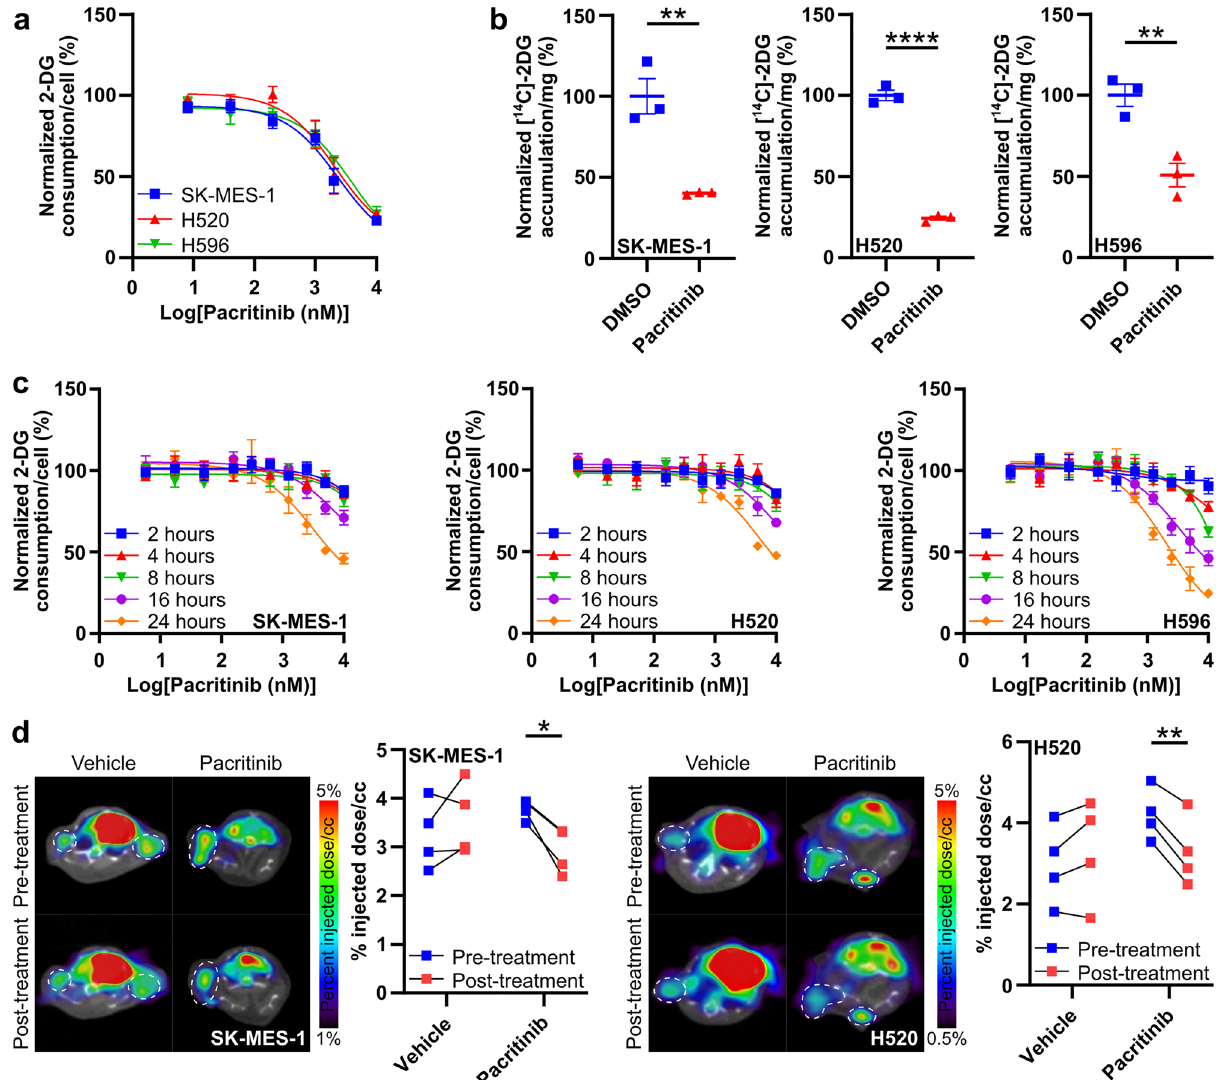
Figure 2. Pacritinib blocks glucose consumption in squamous cell lung cancer cell lines. ( a ) Glucose consumption as measured using a high-throughput assay in SK-MES-1, H520, and H596 cells treated with vehicle or pacritinib across a range of concentrations. ( b ) Glucose consumption as measured by [ 14 C]2-DG accumulation in SK-MES-1, H520, and H596 cells treated with vehicle or pacritinib. ( c ) Glucose consumption in SK-MES-1, H520, and H596 cells treated with vehicle or pacritinib for 2, 4, 8, 16, and 24 h. ( d ) [ 18 F]FDG PET images and quantification of [ 18 F]FDG accumulation in SK-MES-1 and H520 xenografts pre- and post- treatment with vehicle or pacritinib. Xenograft tumors encircled in white dotted lines. * P < 0.05; ** P < 0.01; **** P <